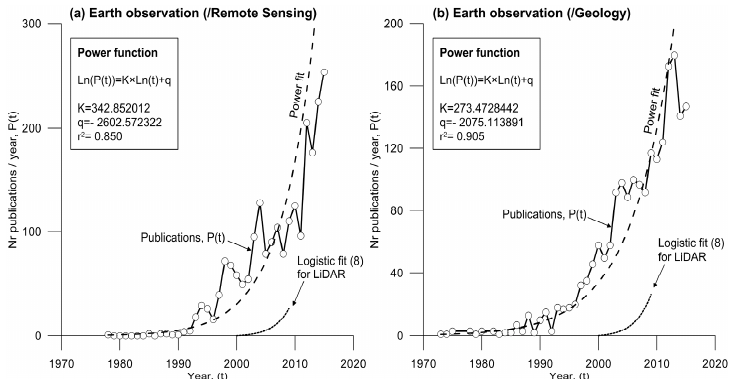
Figure 1. Evolution of the number of publications per year (dots) in the database Web of Science (WOS) containing the term “Earth observation” in the field of TOPICS between 1968 and 2015. Note that the searches are restricted to ( a ) “Remote Sensing”; and ( b ) Geology in the Web of Science. The dashed lines represent the best fit power function of the dots. The dotted lines correspond to the logistic fit performed by [8] for the terms “LiDAR” or “Laser scanning” in the GEOREF database.